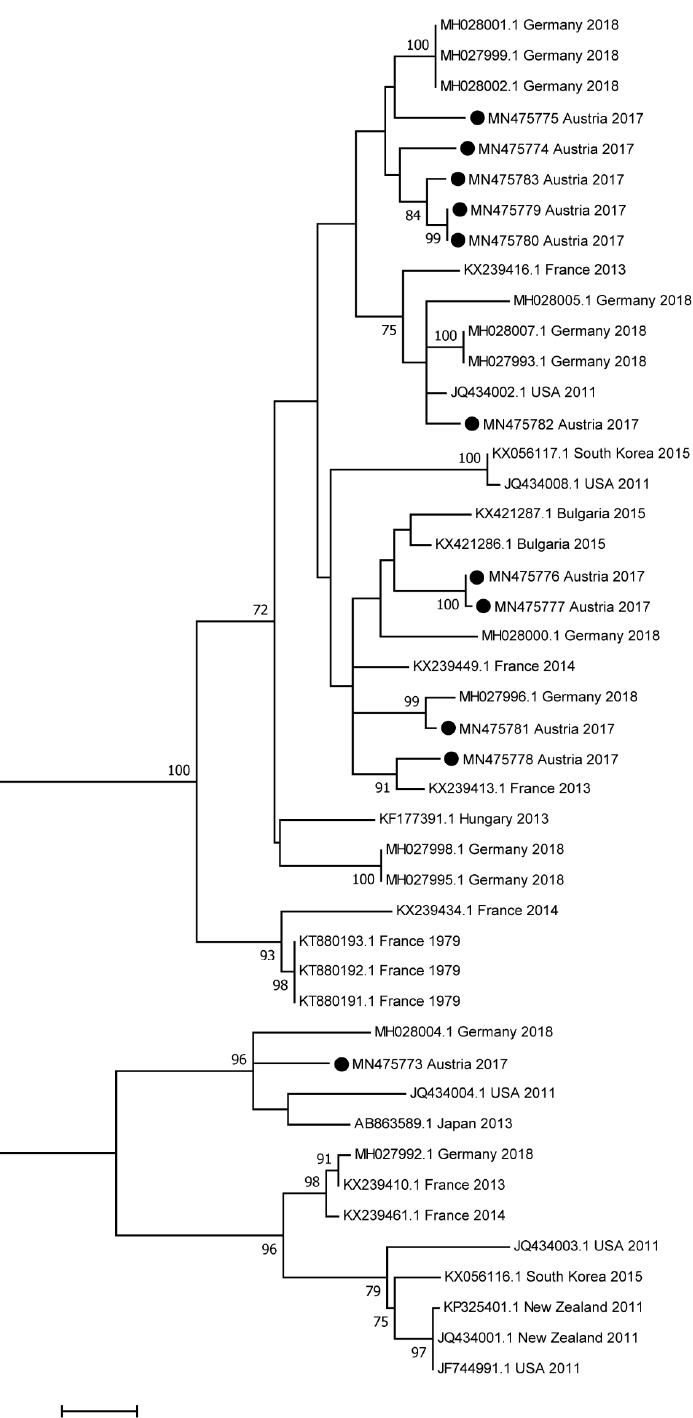
Figure 2. Maximum-likelihood phylogeny based on partial NS5B sequences of EqHV. In addition to sequences obtained from Austrian horses, the phylogenetic tree contains previously published complete genome sequences of EqHV retrieved from the GenBank database, as well as sequences of six isolates, which originated in France [12]. Di ff erent samples are identified with their accession number, country of origin and year of sampling or, if not applicable, year of publication. The analysis involved 45 nucleotide sequences. All positions containing gaps and missing data were eliminated, whereby a total of 258 positions were included in the final dataset. Bootstrap values < 70% are not shown. The scale bar represents the number of substitutions per site. Black circles indicate samples obtained in this